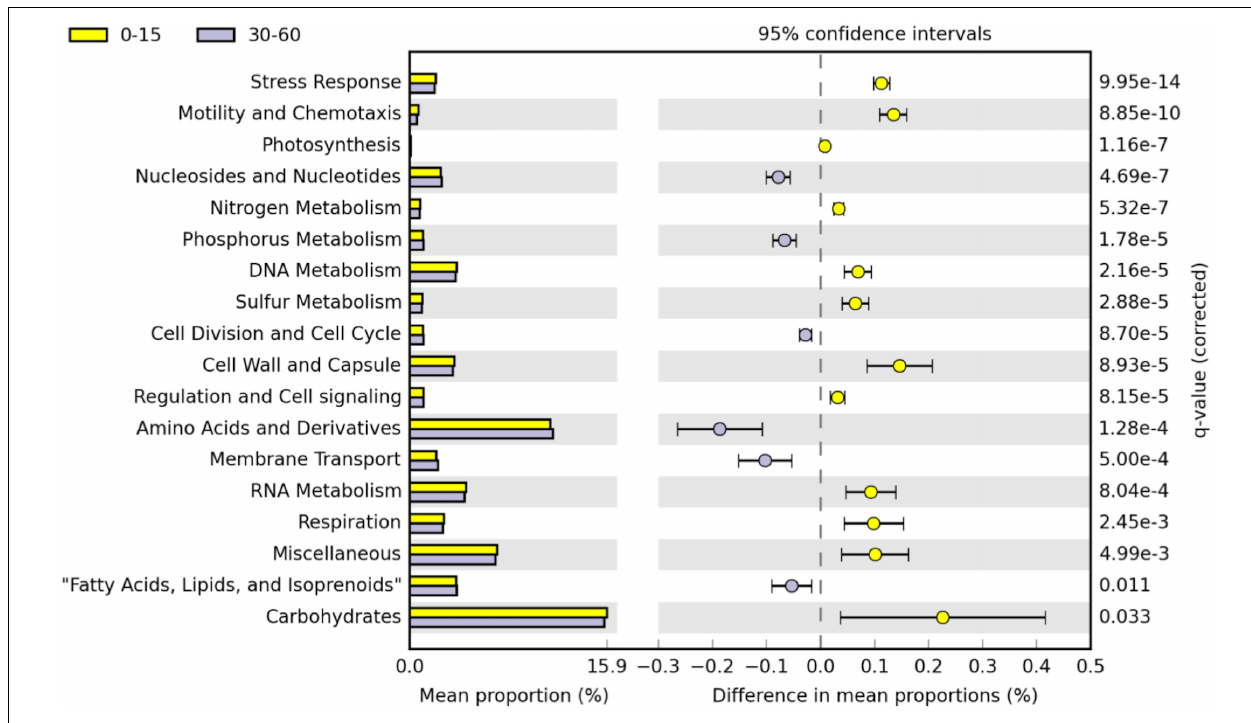
FIGURE 4 | Post hoc plot of functional profiles at subsystem level 1 in the 0–15 cm and 30–60 cm soil layers in STAMP. Groups represented in 0–15 cm (yellow) correspond to positive differences between proportions and groups represented in 30–60 cm (purple) correspond to negative differences between proportions. The comparison was accomplished including 15 replicates. Corrected p -values were calculated using Benjamini–Hochberg FDR approach ( p < 0.05). Only significant different functional level1 categories between the 0–15 cm and 30–60 cm soil layers are